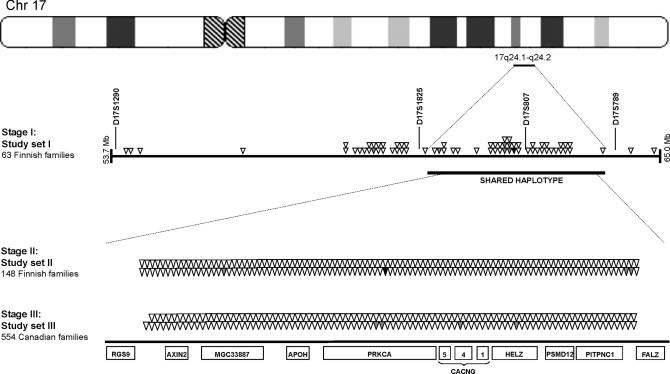
Schematic Representation of the MS Locus on Chromosome 17q24Positions of the SNPs used in stages I, II, and III are shown with arrowheads. Grey arrowheads indicate SNPs showing evidence for association: stage I, p < 0.05; stage II, p < 0.01. SNP rs887797 showing evidence for association in the two independent Finnish study sets (Study sets I and II) is shown with a black arrow. The horizontal bar indicates the position of the critical MS region identified by haplotype analysis in our previous study [21]. The positions of the genes mapping to the locus are shown as boxes below.